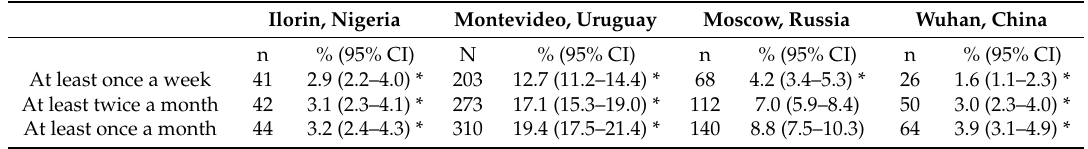
Table 1. Heavy episodic drinking five or more drinks for three levels of frequency of heavy drinking (at least once a week, at least twice a month at least once a month) by